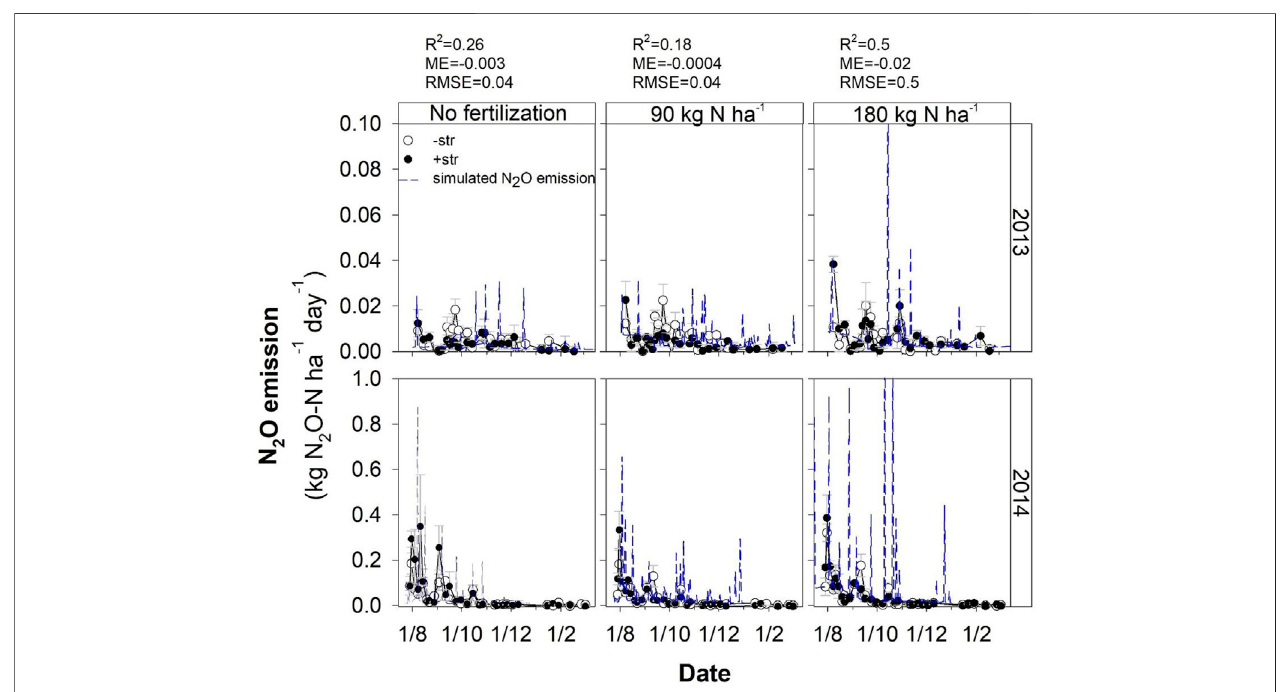
Superscript letter indicates statistical difference among fertilizer levels at p < 0.05.